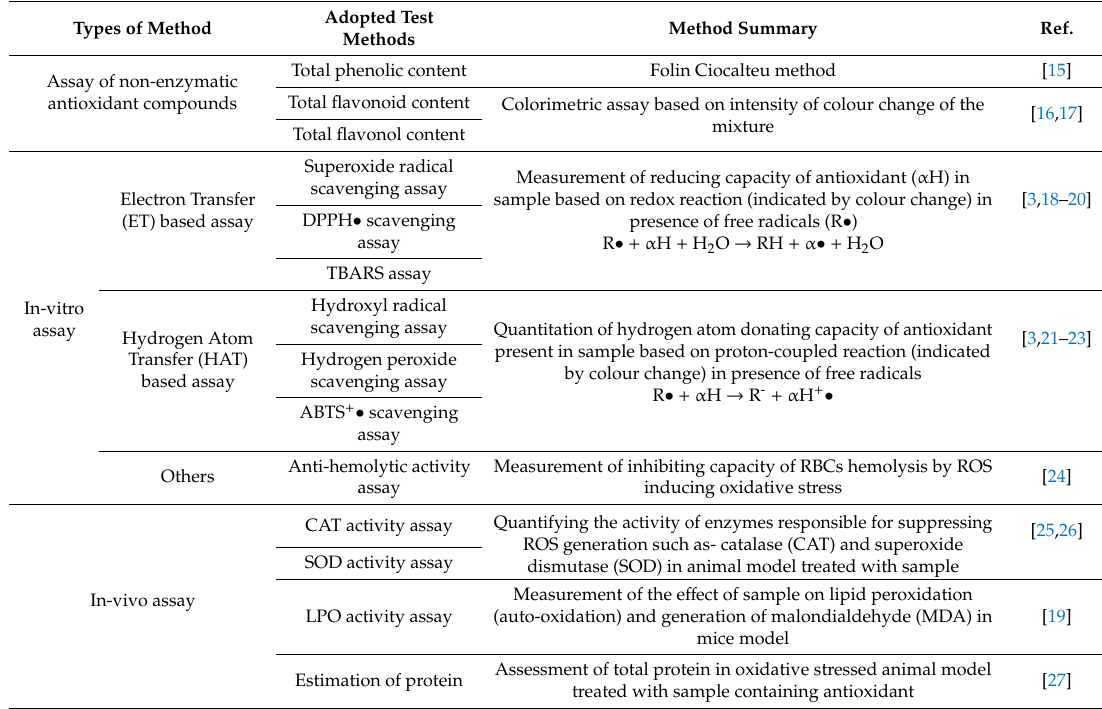
Table 1. Methods adopted for assessment of antioxidant activity of processed and unprocessed lupin